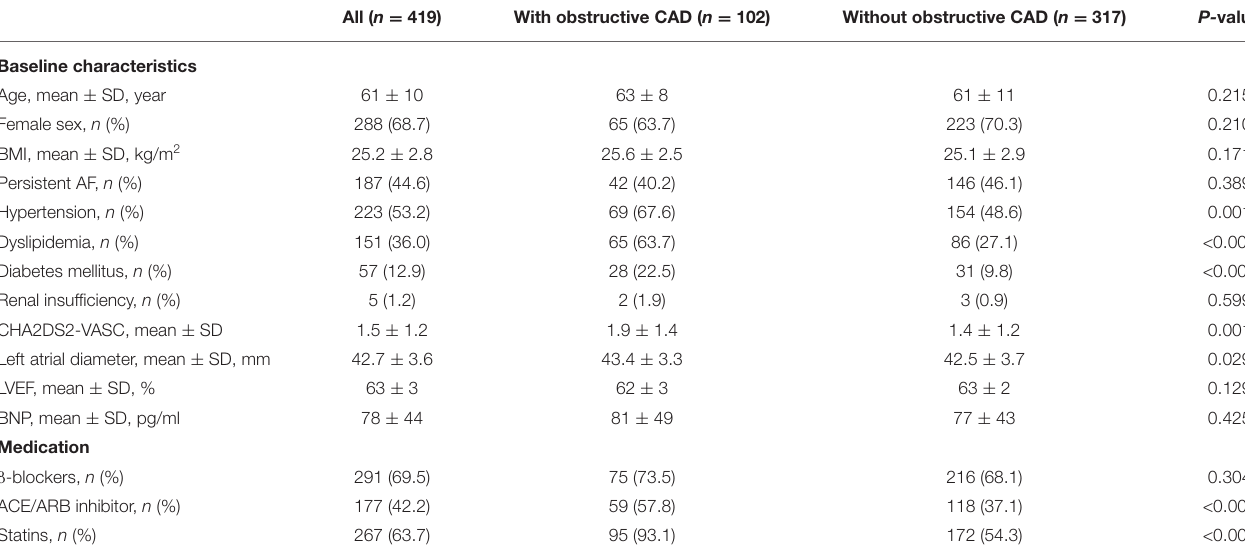
TABLE 1 | Baseline characteristics of the patients with and without obstructive coronary artery disease. All ( n = 419) With obstructive CAD ( n = 102) Without obstructive CAD ( n = 317) P- value